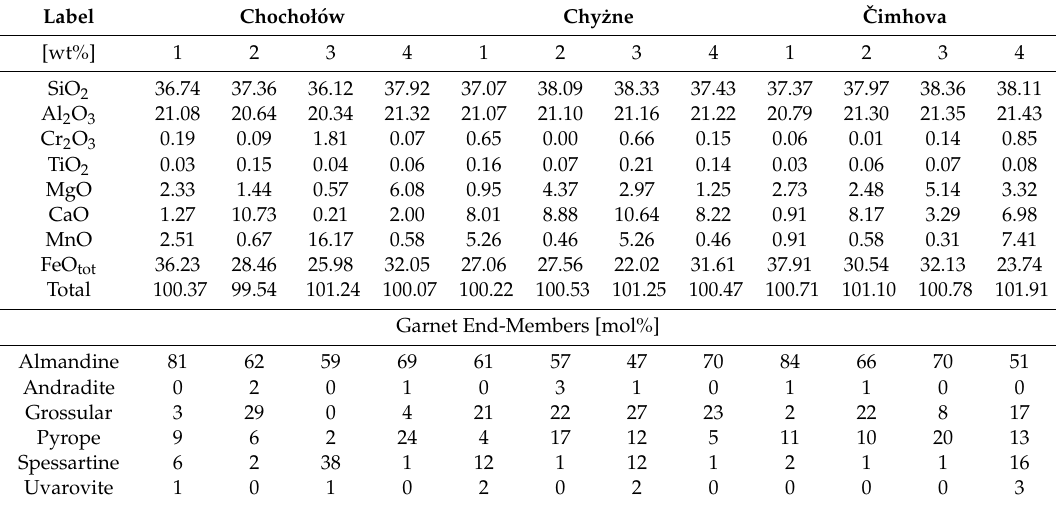
Table 3. Representative analyses of garnet from the studied sites.